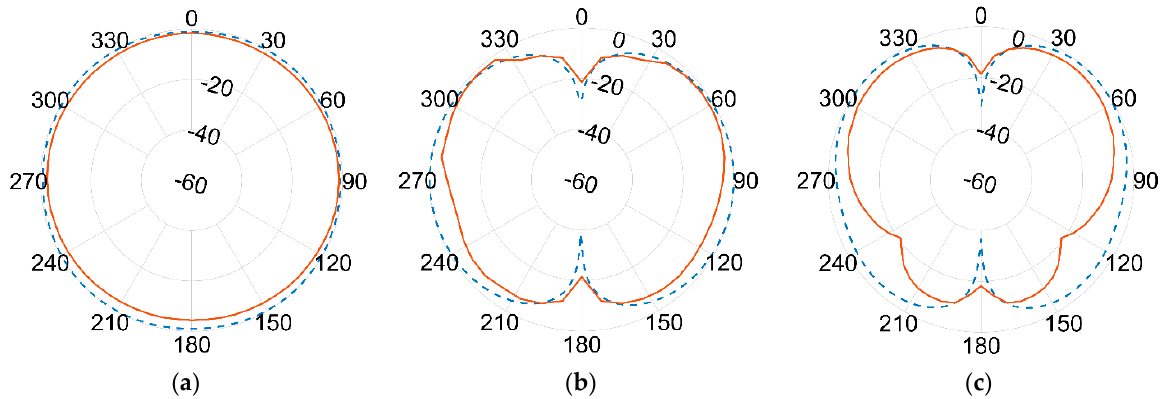
Figure 23. Normalized gain pattern of the FR-4 prototype at 1.09 GHz, ( a ) XY plane, ( b ) XZ plane, and ( c ) YZ plane—Simulated (blue dashed line) and Measured (red line) data in dB.